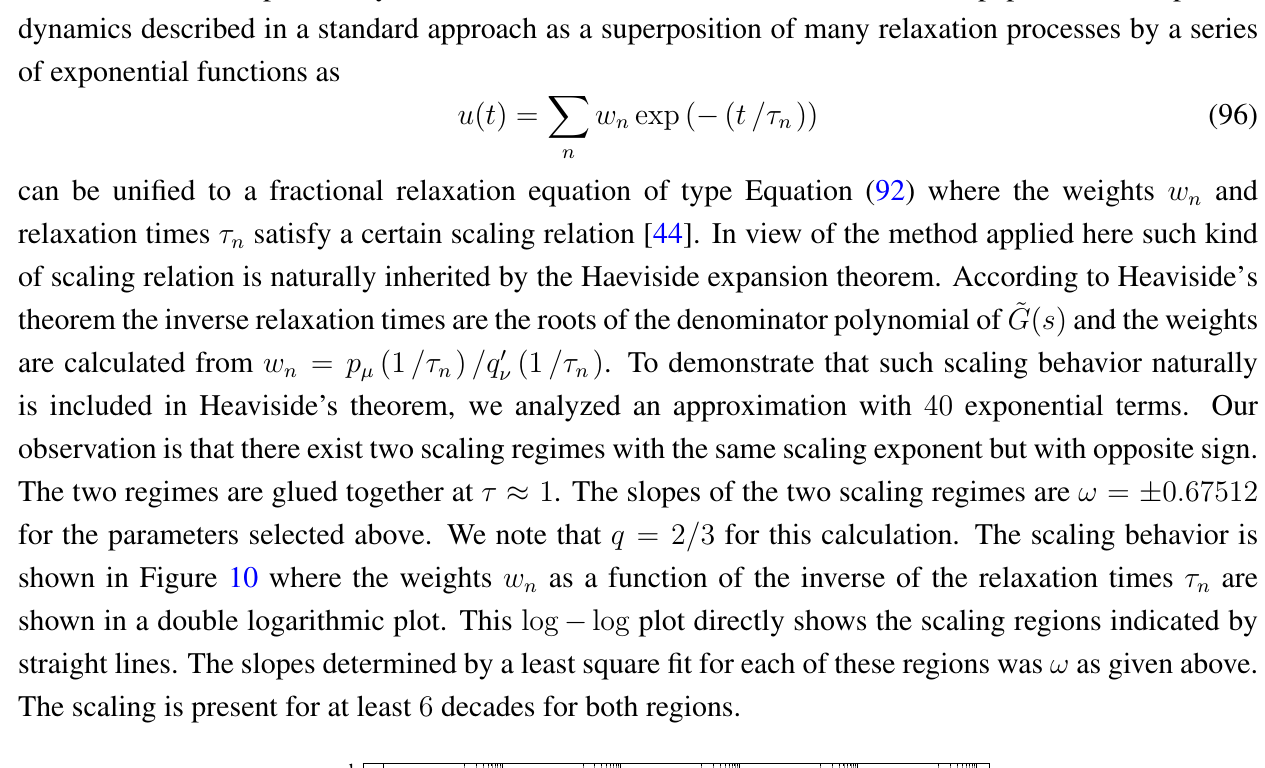
as a function of 1 / (cid:28) for a solution with n n = 1 , (cid:28) = 1 = 2 , q = 2 = 3 , and n = 50 0